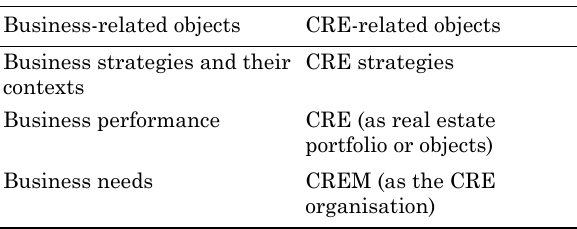
Table 4. Business and CRE-related cognitive objects in